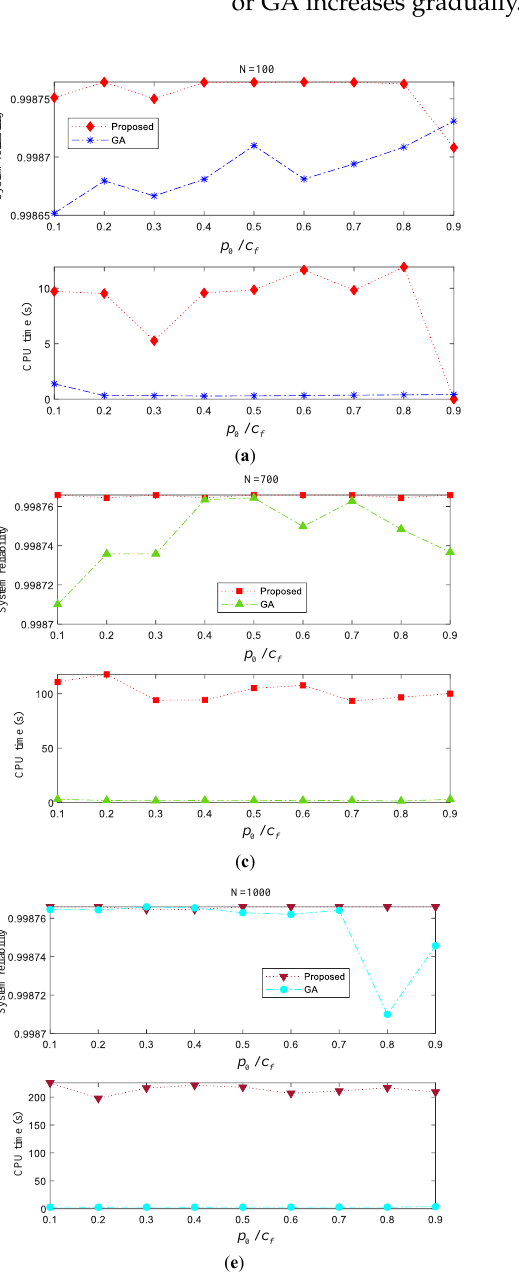
Table 1. Optimal solutions of the Lin/Con/2/10:F system